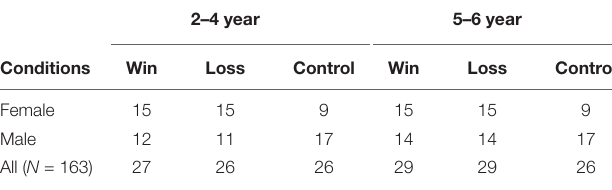
TABLE 1 | Number of participants by age, gender, and experimental